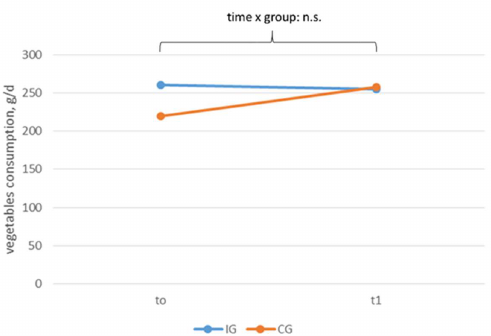
Int. J. Environ. Res. Public Health 2021 , 18 , x Figure 6. Vegetable consumption according to time and group, n.s. p > 0.05. Figure 6. Vegetable consumption according to time and group, n.s. p > 0.05.